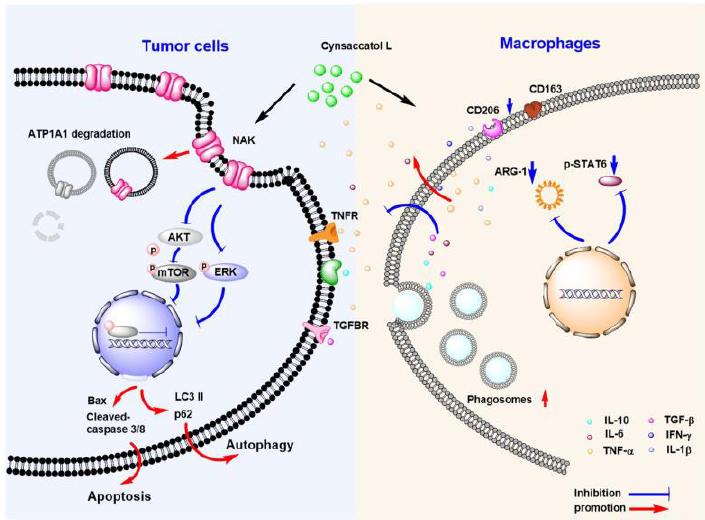
Figure 8. Schematic diagram of the dual anti-proliferation activity of cynsaccatol L.